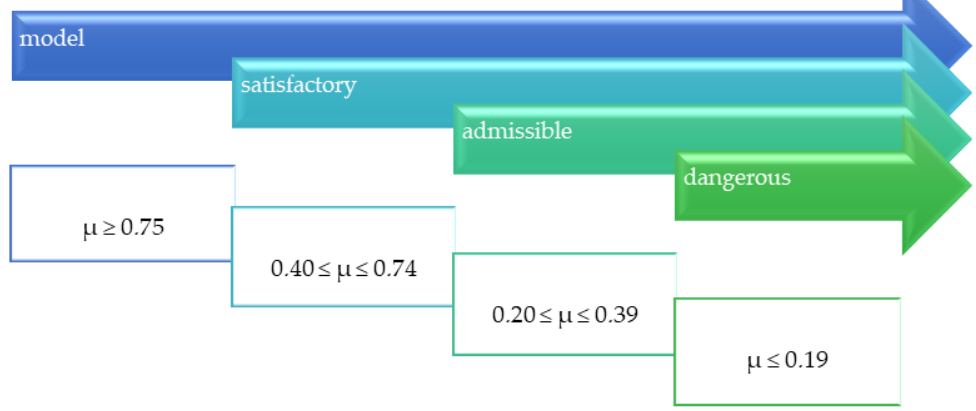
Figure 4. Slip resistance of floors depending on the value of the dynamic coefficient of friction µ